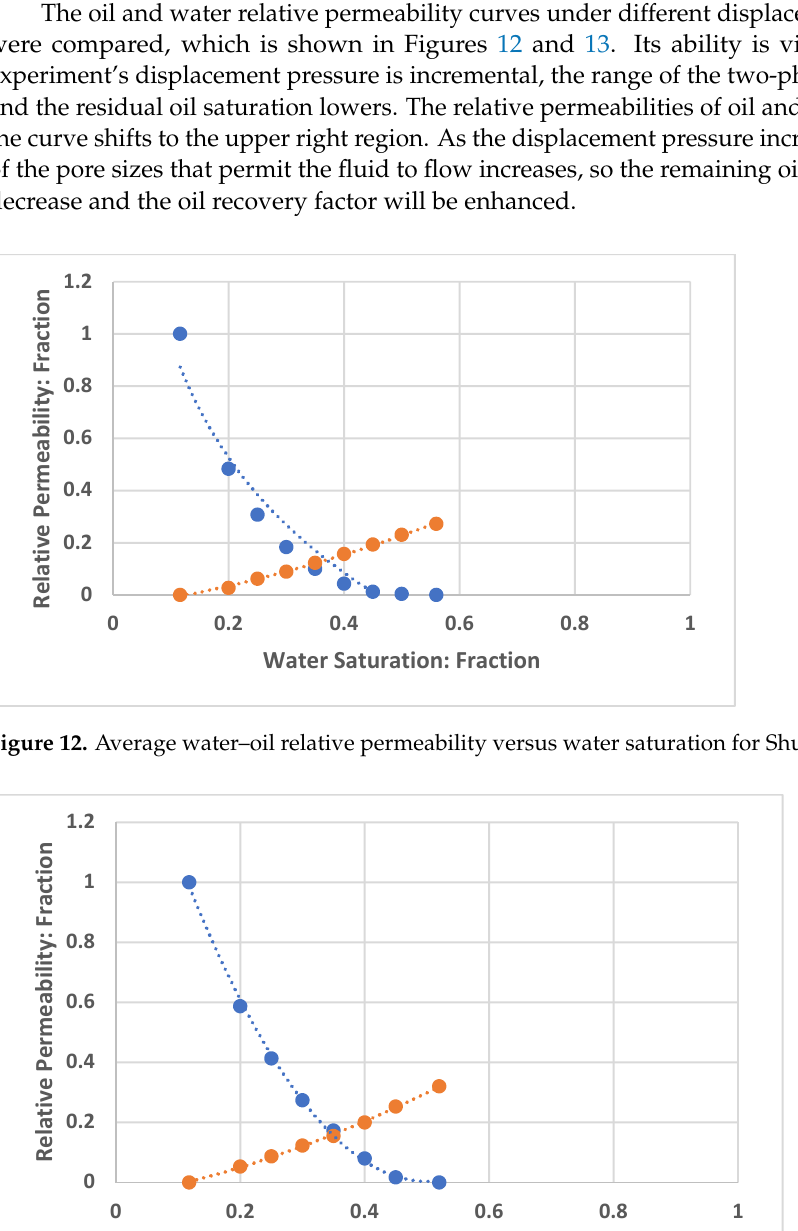
Figure 13. Average water–oil relative permeability versus water saturation for Hummar for ‐ mation.